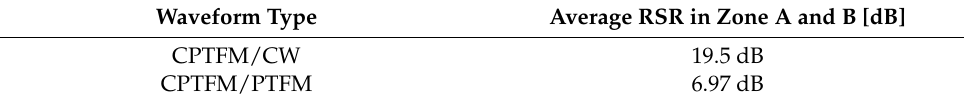
Table 3. Simulated average RSR gain of the CPTFM over the CW and PTFM